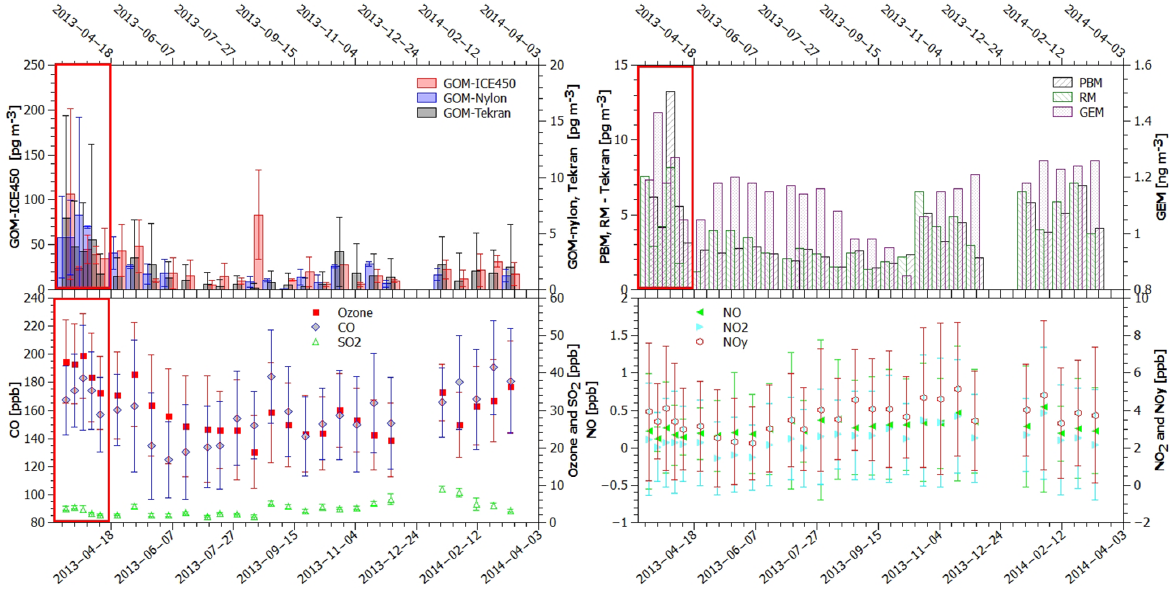
Figure 4. Temporal variation of GOM concentrations (mean ± standard deviation, bi-week average); outlined rectangle indicates a polluted event with high Hg, CO, and ozone concentrations. Data are missing for 3 weeks because it was not collected. Tekran ® data are presented when > 75% of the data were available and membrane data are shown when above the method detection limit. Table 2. Modeled (multiple-resistance model) and measured (surrogate surfaces) GOM dry deposition (ngm − 2 h − 1 ) ; GOM concentrations used to calculate for modeled results are from the Tekran ® data and corrected by compounds’ corresponding ratios from Gustin et al. (2015, 2016). Model resistance for the unknown compound was calculated using the Tekran ® data multiplied by 3. The tentative GOM compounds are identified from nylon membrane